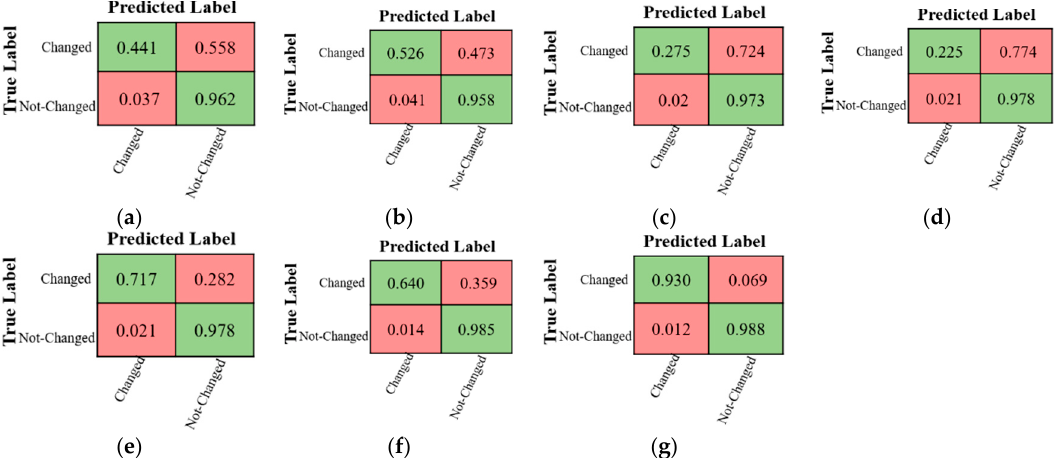
Figure 23. The confusion matrices of different CD methods for the PolSAR-San Francisco1 dataset. ( a ) CVA-SVM, ( b ) MAD-SVM, ( c ) PCA-SVM, ( d ) IR-MAD -SVM, ( e ) SFA-SVM, ( f ) 3D-CNN, and ( g ) Proposed Method.